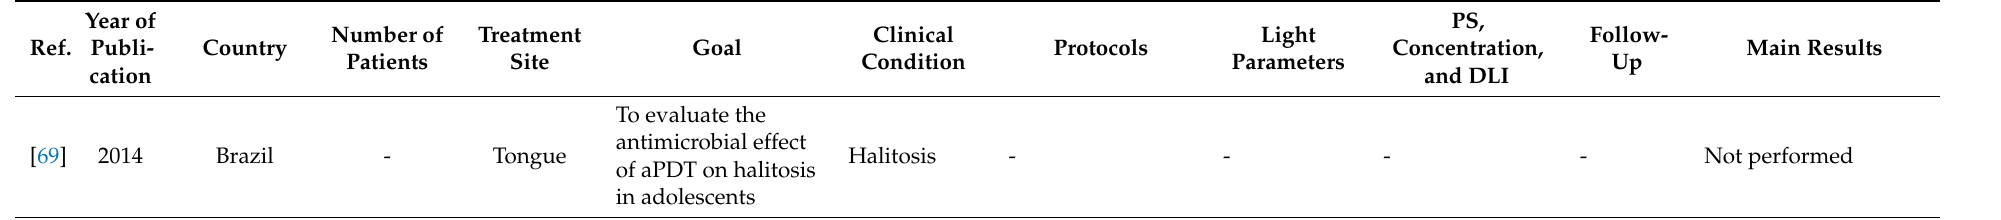
Table 2. Randomized clinical trials that evaluated aPDT for the treatment of halitosis.